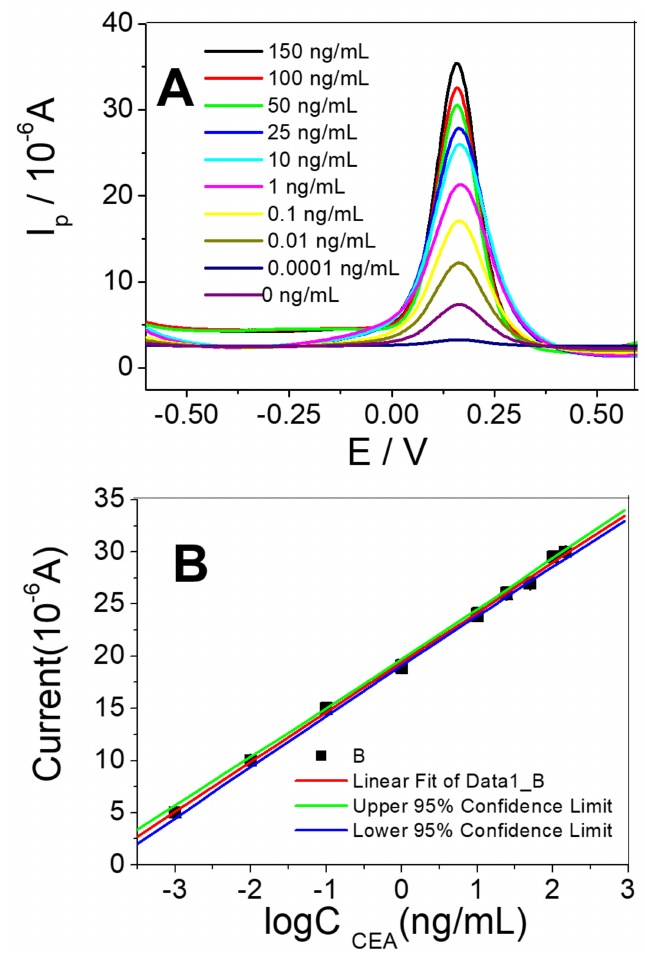
Figure 5. ( A ) DPV response of the immunosensor to di ff erent concentrations of CEA (top-down: 150, 100, 50, 25, 10, 1, 0.1, 0.01, 0.001, 0 ng / mL); ( B ) Calibration curve of the immunosensor to di ff erent concentrations of